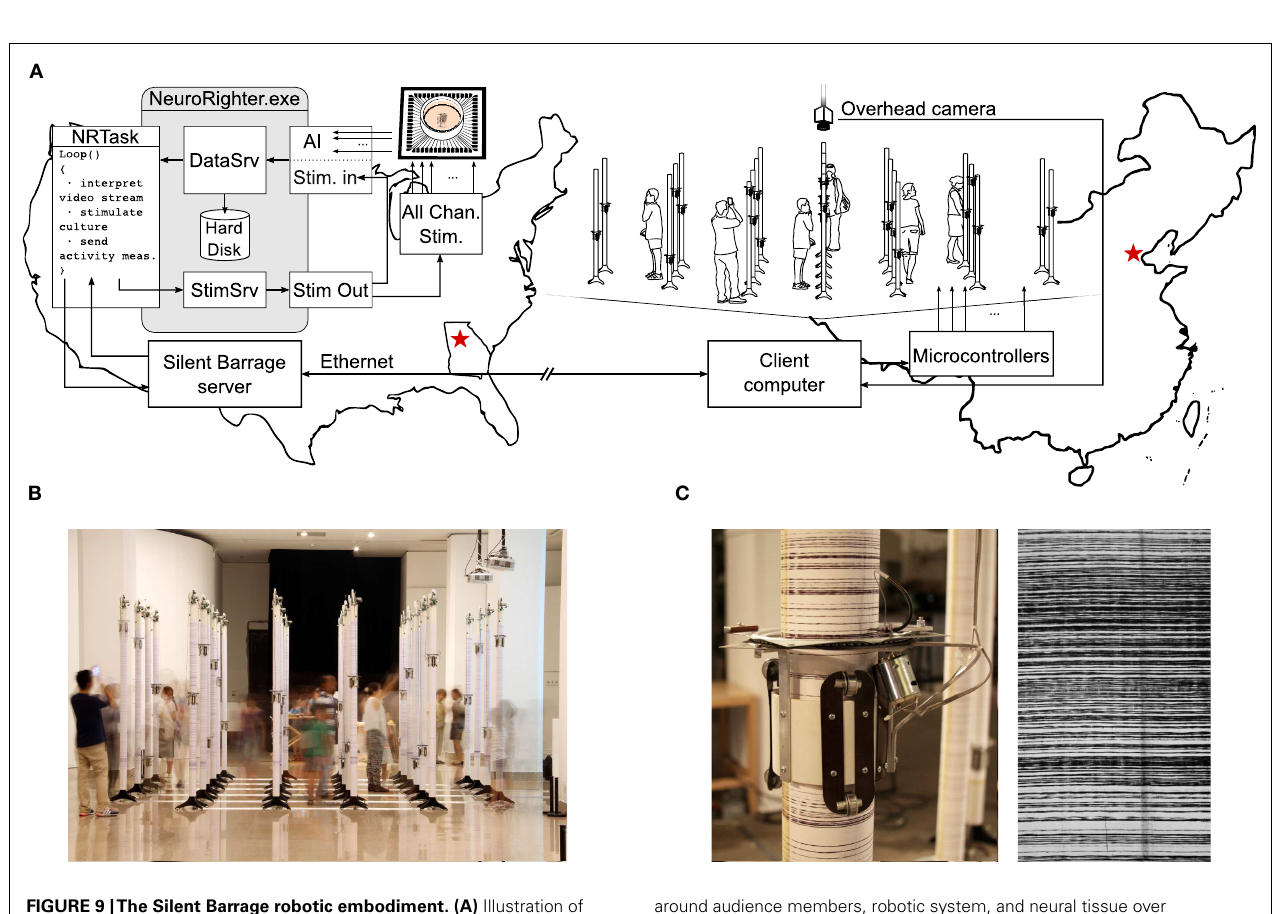
FIGURE 9 |The Silent Barrage robotic embodiment. (A) Illustration of the Silent Barrage “organism” during its exhibition at the National Art Museum of China (NAMOC), in Beijing. Spatial patterns of action potentials recorded from a dissociated cortical culture are used to drive the robotic body. A video stream of visitors to the exhibition are interpreted by NeuroRighter’s plugin protocol and used to control multichannel electrical stimulation though the MEA, closing the loop